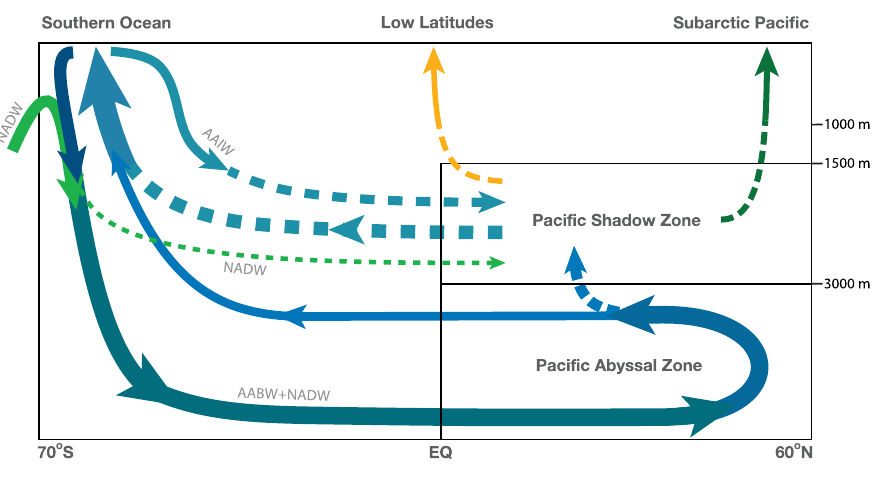
Fig. 6 Deep Paci fi c ventilation schematic. Schematic summarizing the major transport pathways by which the Paci fi c Shadow Zone (PSZ) and the Paci fi c Abyssal Zone (PAZ) of the North Paci fi c exchange water with the surface ocean. Solid lines indicate overturning-dominated transport while dashed lines indicate diffusion-dominated transport. Bright green indicates North Atlantic ventilated water (NADW), while blue tones indicate waters last ventilated in the Southern Ocean (AABW and Antarctic intermediate water (AAIW)) or destined for re-exposure in the Southern Ocean. Amber and dark green arrows illustrate shadow-zone waters bound for re-exposure in low latitudes and in the subarctic Paci fi c, respectively. The thickness of the arrows scales approximately with the volume fl ow rate of each transport pathway, with a reference value of 7.3 Sv for the in fl ow of high-latitude-sourced water into the PAZ (thick solid blue-green arrow, a mixture of AABW and NADW). For the transport timescales associated with the pathways illustrated here see Fig. 3g – j. Like all circulation schematics, this picture is a simpli fi cation; for a detailed, rigorous quanti fi cation of the transports refer to Figs. 4 and